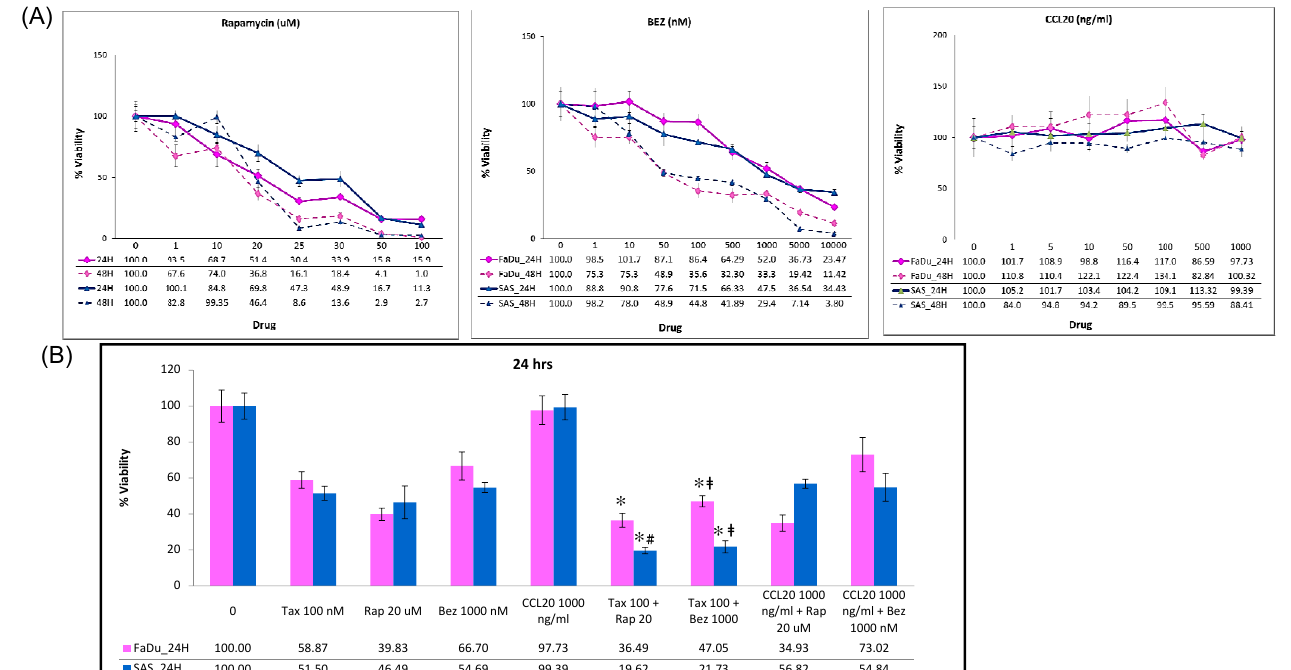
Figure 5. Effect of mTOR inhibitors combined with docetaxel or CCL-20 on cell growth. ( A ) FaDu and SAS cells were treated with rapamycin (1 to 100 µ M), BEZ235 (1 to 100 µ M), and CCL-20 (1 µ g/mL) for 24 or 48 h, and then cells were treated with WST1 for 3 h. Cell viability was determined by measuring absorbance at 450 nm. ( B ) FaDu and SAS cells were treated with docetaxel (0.1 µ M), rapamycin (20 µ M), BEZ235 (1 µ M), CCL-20 (1 µ g/mL), or a combination thereof for 24 h, and cell viability was determined by measuring absorbance at 450 nm. Data are expressed as the mean ± SD ( n = 6). * p < 0.05 vs. Tax 100 nM, # p < 0.05 vs. Rap 20 µ M, ‡ p < 0.05 vs. BEZ 1 µ